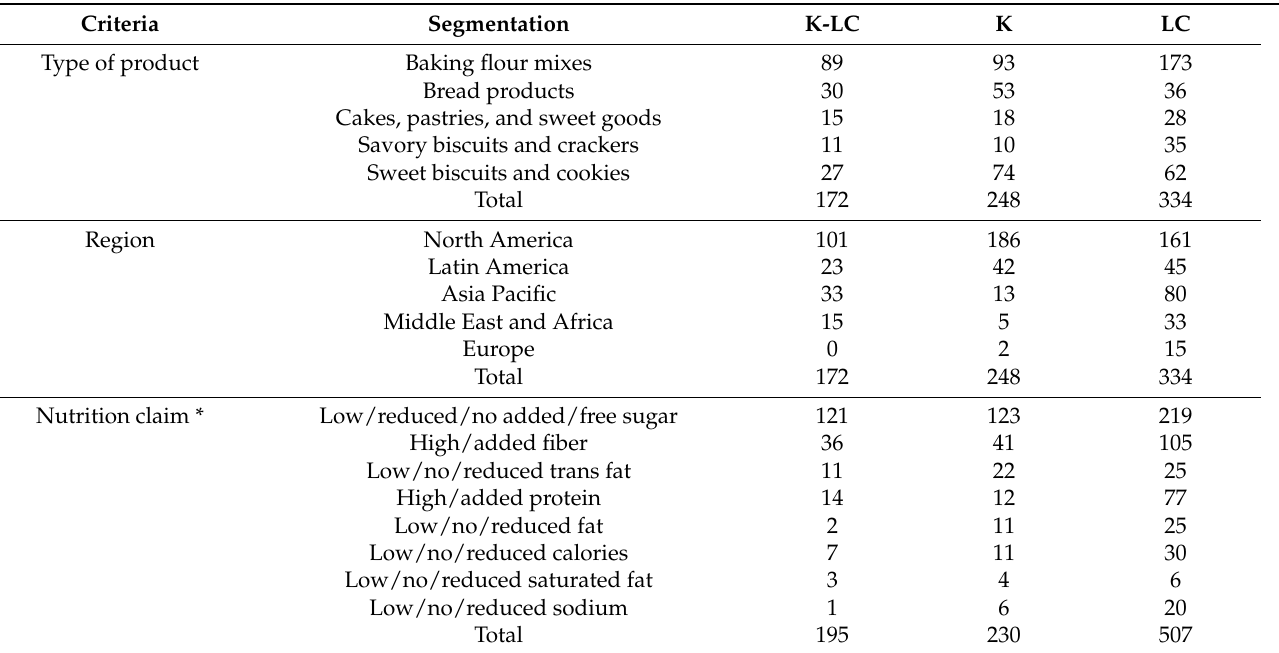
Table 1. Categorization of gluten-free bakery products labeled ketogenic (K) and/or low-carb (K- LC,